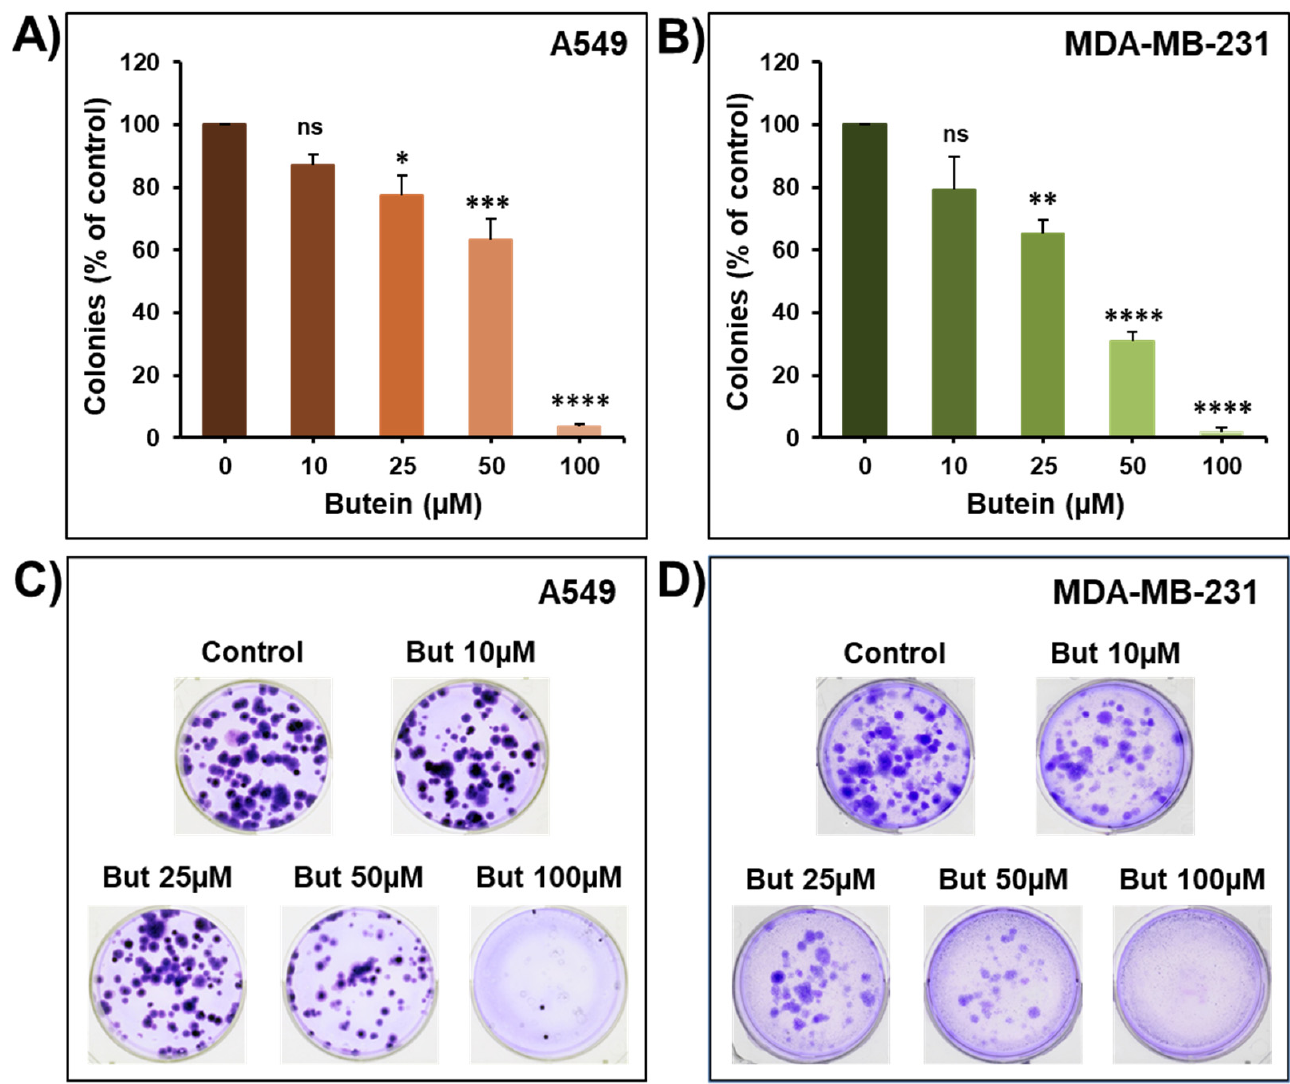
Figure 2. Effect of butein on colony growth. The growth of cancer cell-derived colonies from A549 ( A ) and MDA-MB-231 ( B ) cells was assessed by measuring the number of the colonies in control and butein-treated wells for seven days. ( C , D ) Representative pictures of the control and butein-treated colonies are shown for A549 and MDA-MB-231 cancer cells. Experiments were repeated at least three times. Columns represent means; bars represent S.E.M. * Significantly different at p < 0.05, ** Significantly different at p < 0.01, *** Significantly different at p < 0.001, **** Significantly different at p < 0.0001. ns—non-significant.